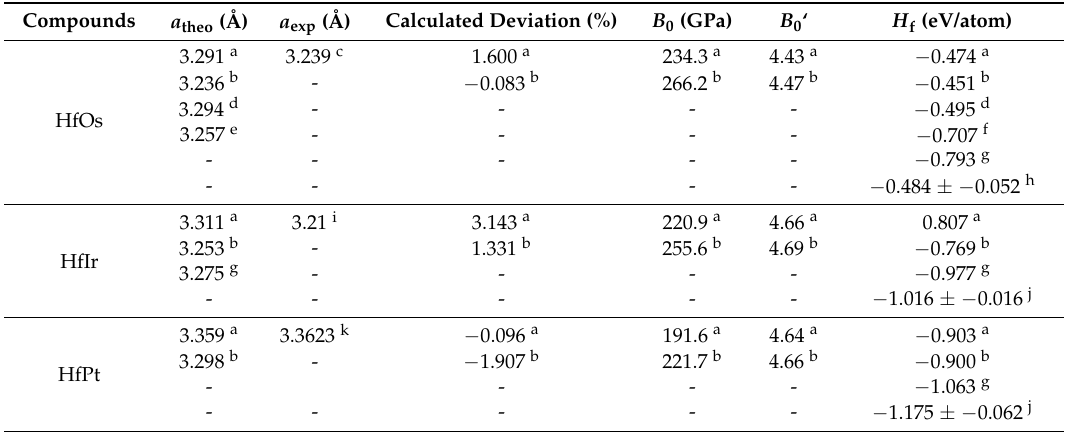
Table 1. The optimized ( a theo ) and experimental ( a exp ) lattice constants, calculated deviations, bulk moduli ( B 0 ) and its pressure derivatives ( B 0 ’), and formation enthalpies ( H f ) for HfX (X = Os, Ir and Pt). Compounds